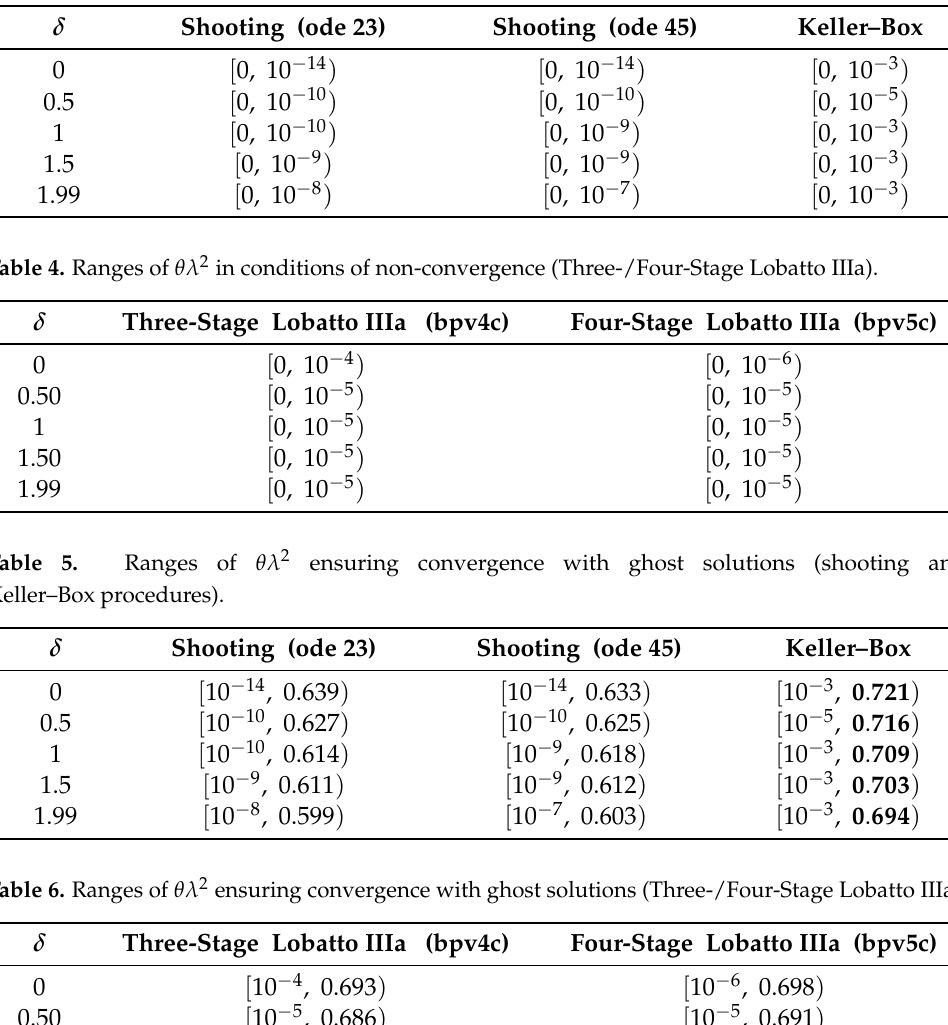
Table 3. Ranges of θλ 2 in conditions of non-convergence (shooting and Keller–Box procedures).